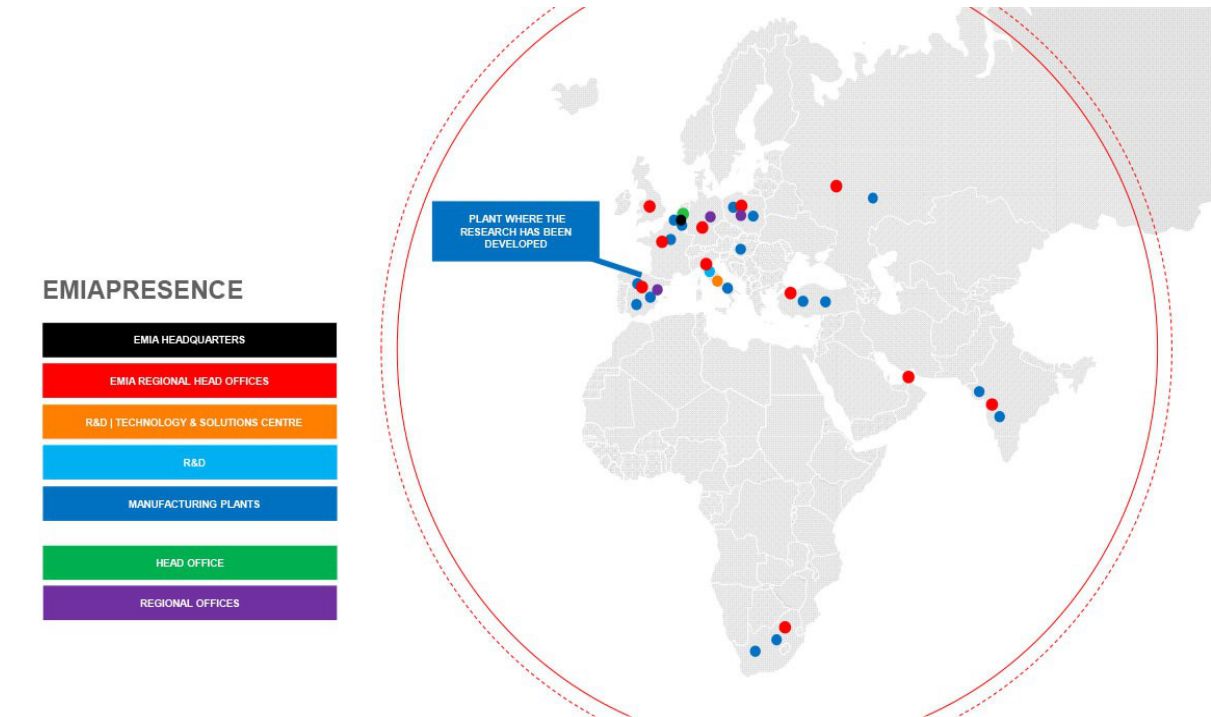
Figure 3. EMIA presence (Company of study,